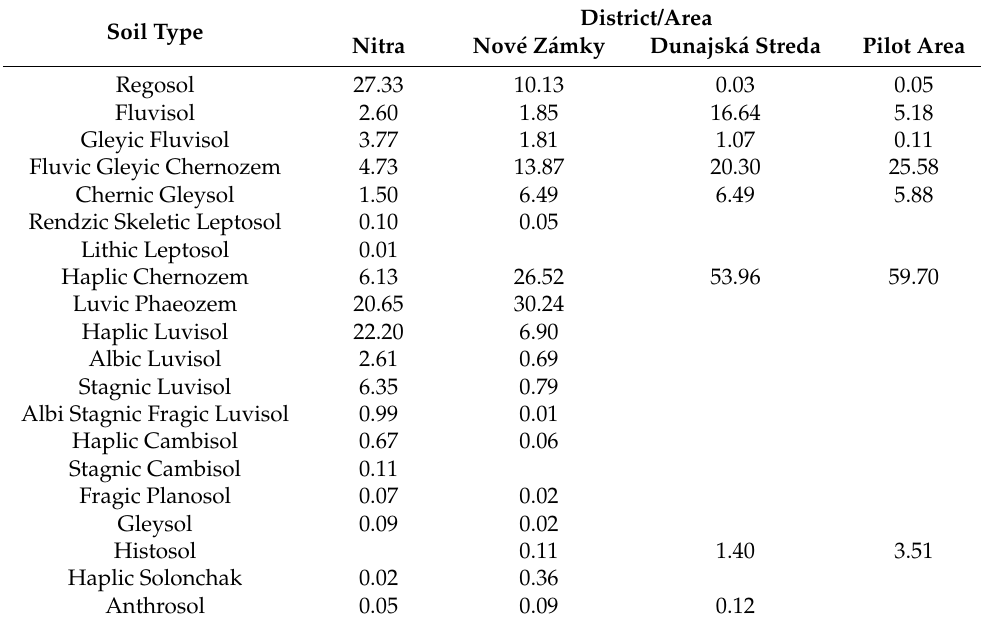
Table 3. Relative share of soil types within UAL of selected districts/areas of